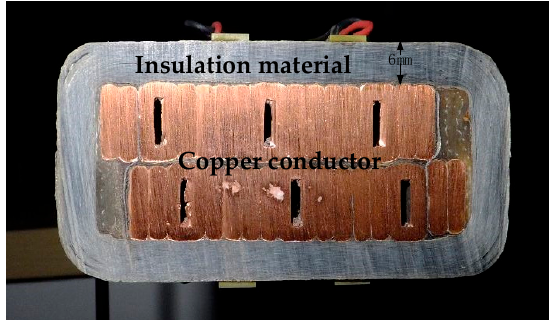
Figure 5. Sectional view of the stator bar .